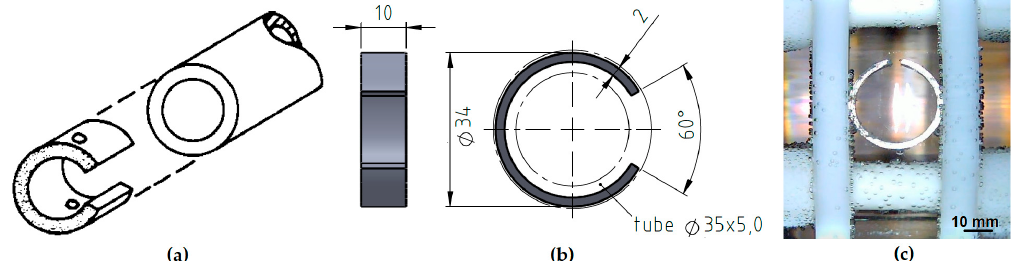
Figure 1. C-ring samples, position in the initial extruded tubes ( a ), sketch with dimensions ( b ) and during stress corrosion in the polyoxymethylene (POM) apparatus ( c ).